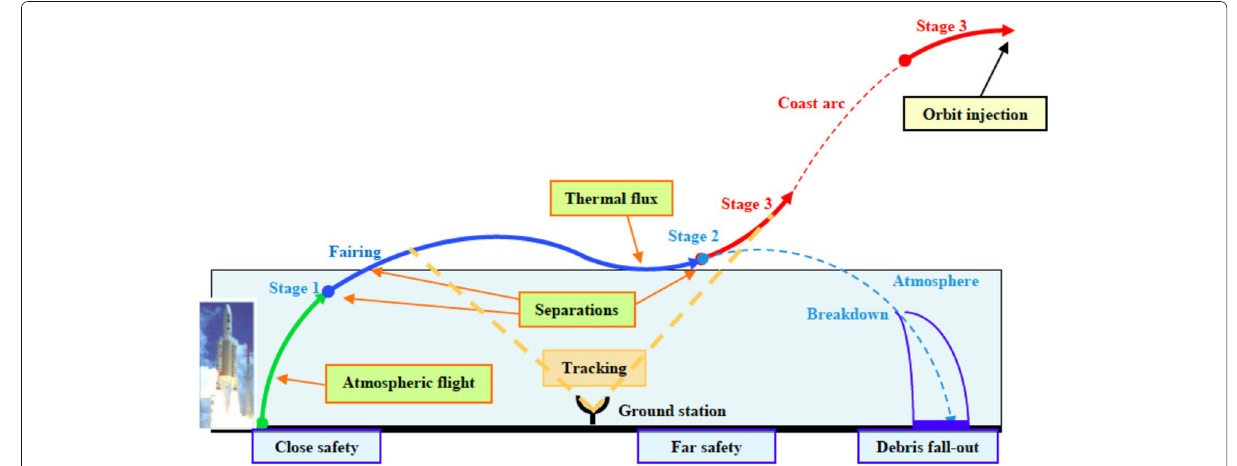
Fig. 1 Ascent trajectory and physical constraints over each ascent phase